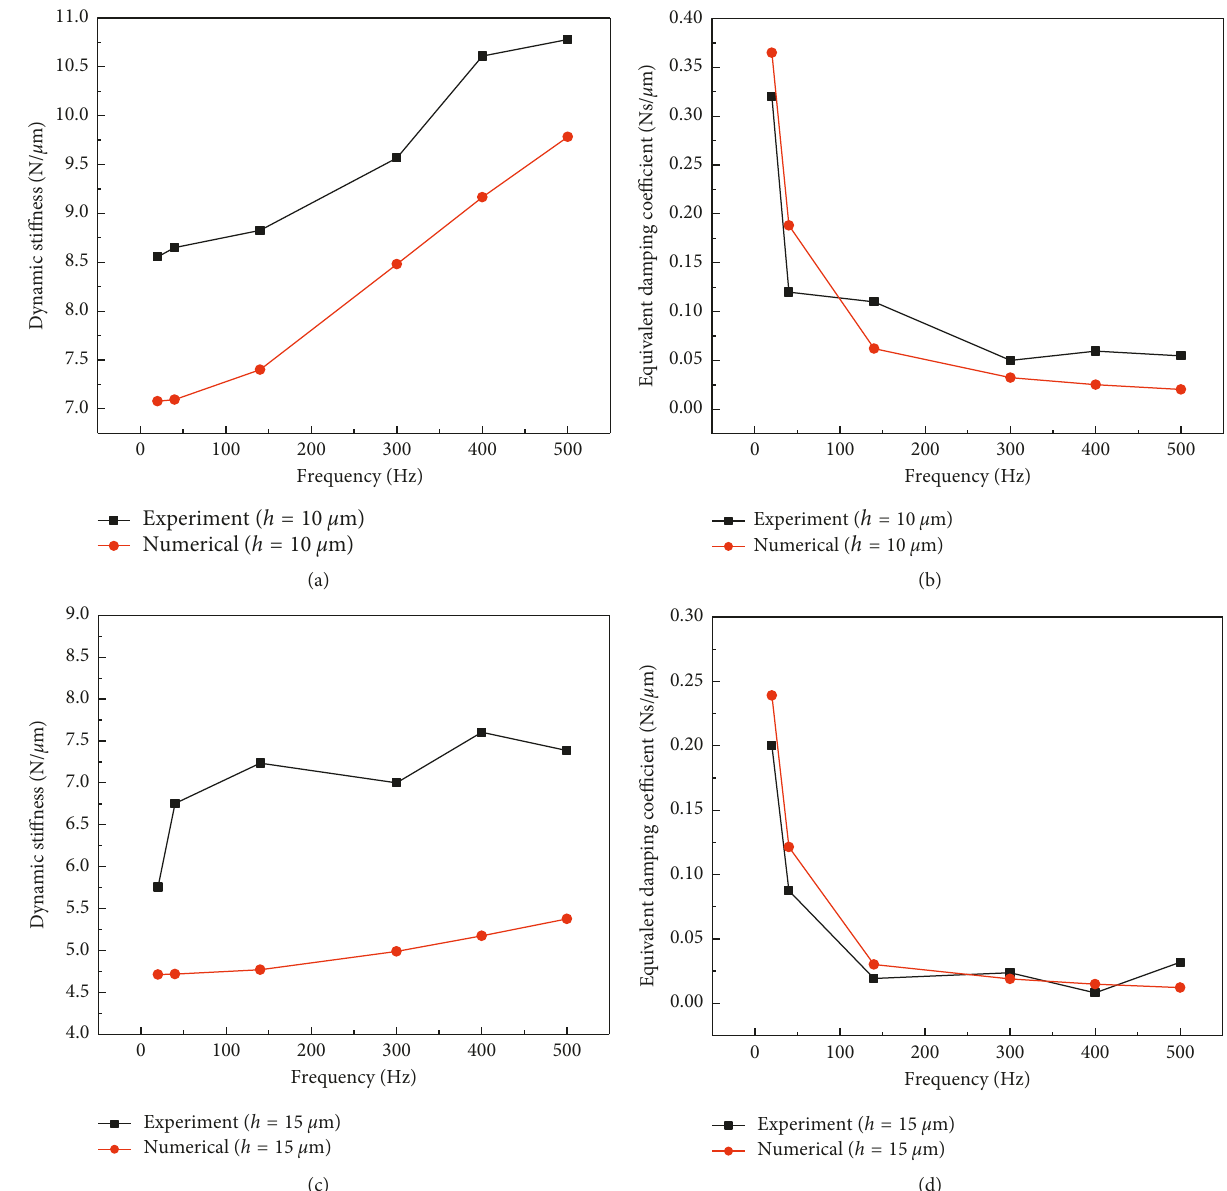
Figure 7: Experimental test data: (a) dynamic stiffness at h � 10 μ m; (b) equivalent damping coefficient at h � 10 μ m; (c) dynamic stiffness at h � 15 μ m; (d) equivalent damping coefficient at h � 15 μ